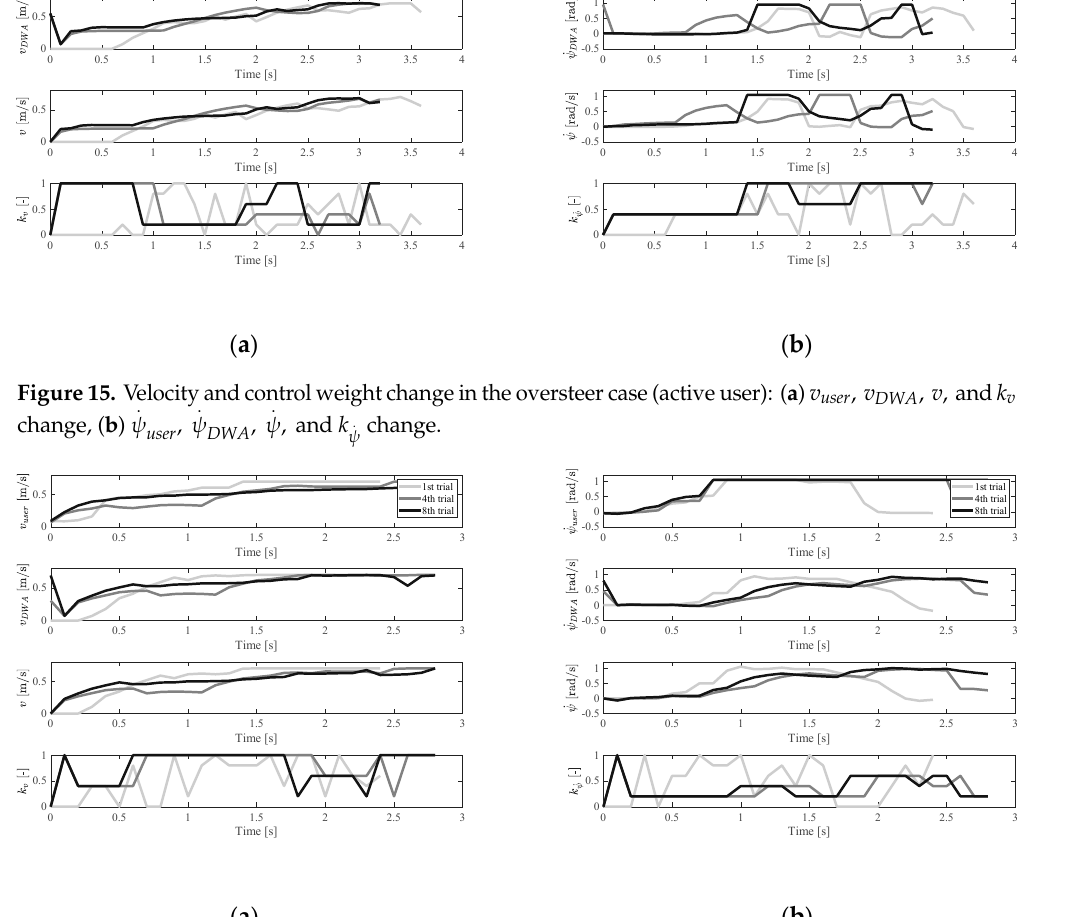
Figure 16. Velocity and control weight change in the oversteer case (passive user): ( a ) (cid:1874) (cid:3048)(cid:3046)(cid:3032)(cid:3045) ,(cid:1874) (cid:3005)(cid:3024)(cid:3002) , (cid:1874), and (cid:1863) (cid:3049) change , ( b ) (cid:2032)(cid:4662) (cid:3048)(cid:3046)(cid:3032)(cid:3045) , (cid:2032)(cid:4662) (cid:3005)(cid:3024)(cid:3002) , (cid:2032)(cid:4662),and (cid:1863) (cid:3103)(cid:4662) change.